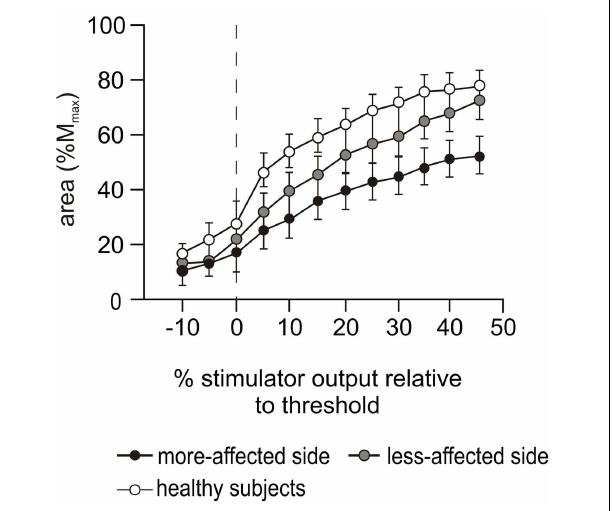
FIGURE 4 | Stimulus–response curves during cortical stimulation . Motor evoked potential (MEP) stimulus–response curves during cortical stimulation at 50% MVC for the more-affected (black circles) and less-affected (gray circles) sides of the stroke patients and the combined dominant and non-dominant sides (white circles) of the healthy subjects. Data are presented as mean ± SEM. MEP areas are normalized to the area of M max evoked during Erb’s point stimulation and presented in 5% increments of maximal stimulator output relative to motor threshold.The dashed vertical line indicates motor